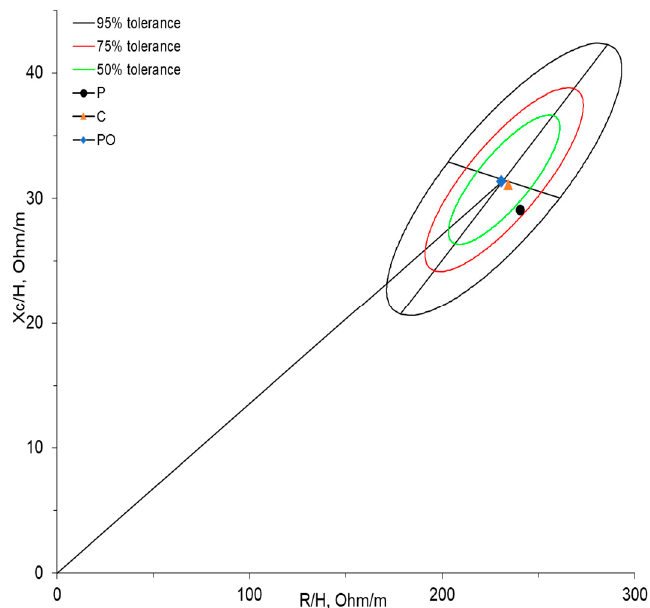
Figure 1. BIVA graphical representation of vector changes in “Key times” selected from the entire study period, using specific tolerance ellipses for volleyball players. Rz/H: Resistance/Height; Xc/H: Reactance/Height; Black circle: pre-season training session (P); Orange triangle: championship (C); Blue rhombus: play-off (PO) periods.